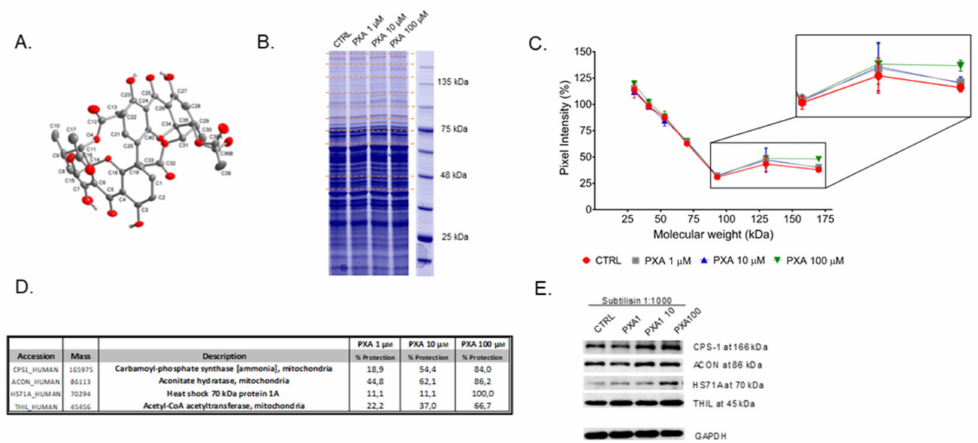
Figure 1. ( A ) Phomoxanthone A (PXA) structure. ( B ) Coomassie stained gel of samples treated without (CTRL) or with 1 µ M, 10 µ M or 100 µ M of PXA and subtilisin at 1:1000 (w / w). Red lines indicate gel regions digested on one SDS-PAGE, as an example. ( C ) Densitometric analysis of the SDS-PAGE gels in Figure S1 reported, through GraphPad Prism, as the pixel intensity of each gel region vs. molecular weight. The major variation of pixel intensity of PXA-treated samples can be observed at MW higher than 75 kDa. ( D ) List of putative PXA interacting proteins together with the percentage of protection calculated as (matches of PXA treated sample – matches of control sample) / (matches of undigested lysate – matches of control sample)*100. (E) Immunoblotting analysis with opportune antibodies using subtilisin at 1:1000 (w / w). Glyceraldehyde 3-phosphate dehydrogenase (GAPDH) has been used as a loading